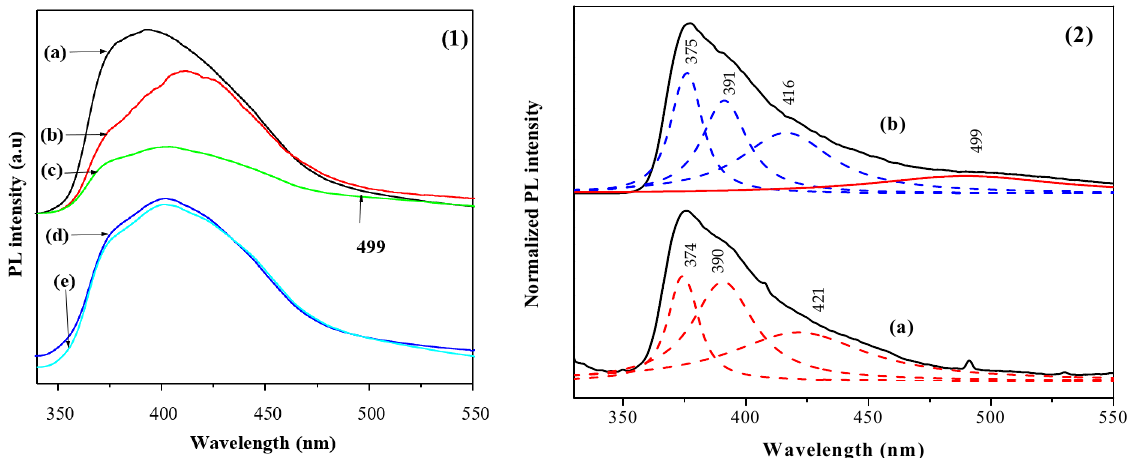
Figure 5. ( 1 ) Stationary PL spectra of ( a ) OVK and of nanocomposite in chloroform ( b ) not annealed and ( c ) annealed at 333 K and in chlorobenzene ( d ) not annealed and ( e ) annealed at 333 K. ( 2 ) PL spectra at T = 87 K of both annealed samples ( a ) OVK and with the OVK/SWCNT composite ( b ).